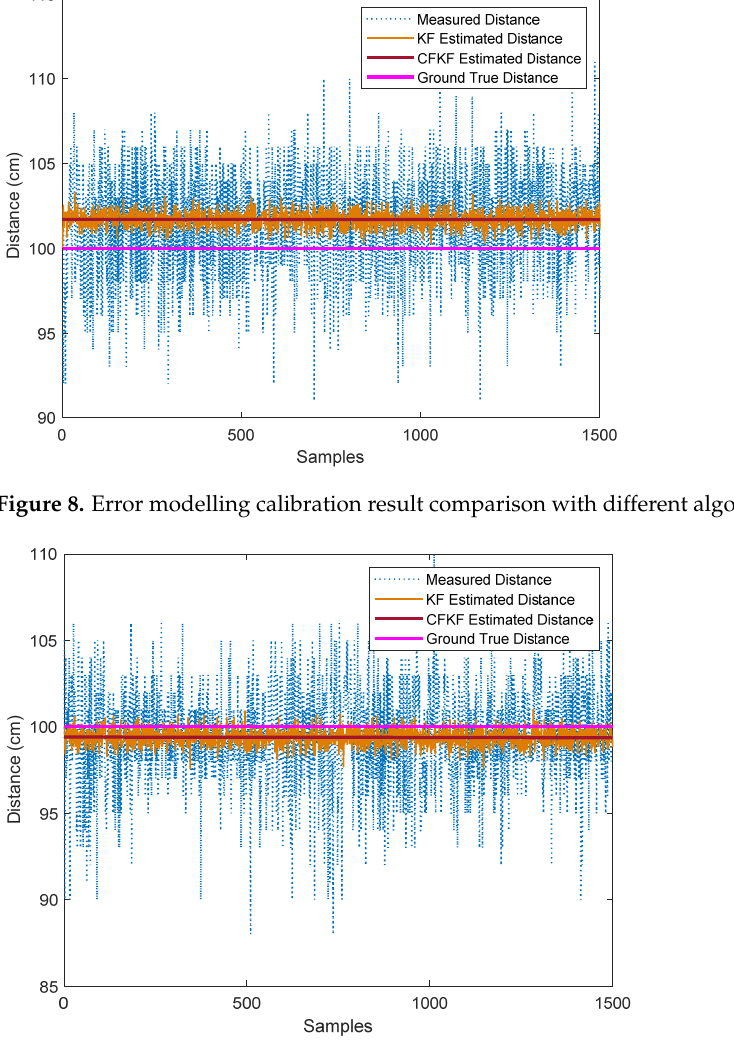
Figure 9. Error modelling calibration result comparison with different algorithms (UWB anchor 3).